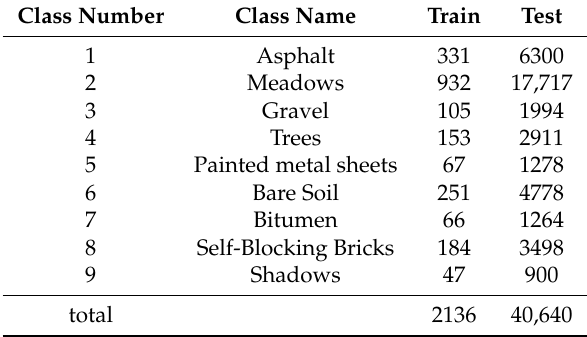
Table 3. Groundtruth classes for PaviaU scene and the corresponding number of training samples and testing samples for classification